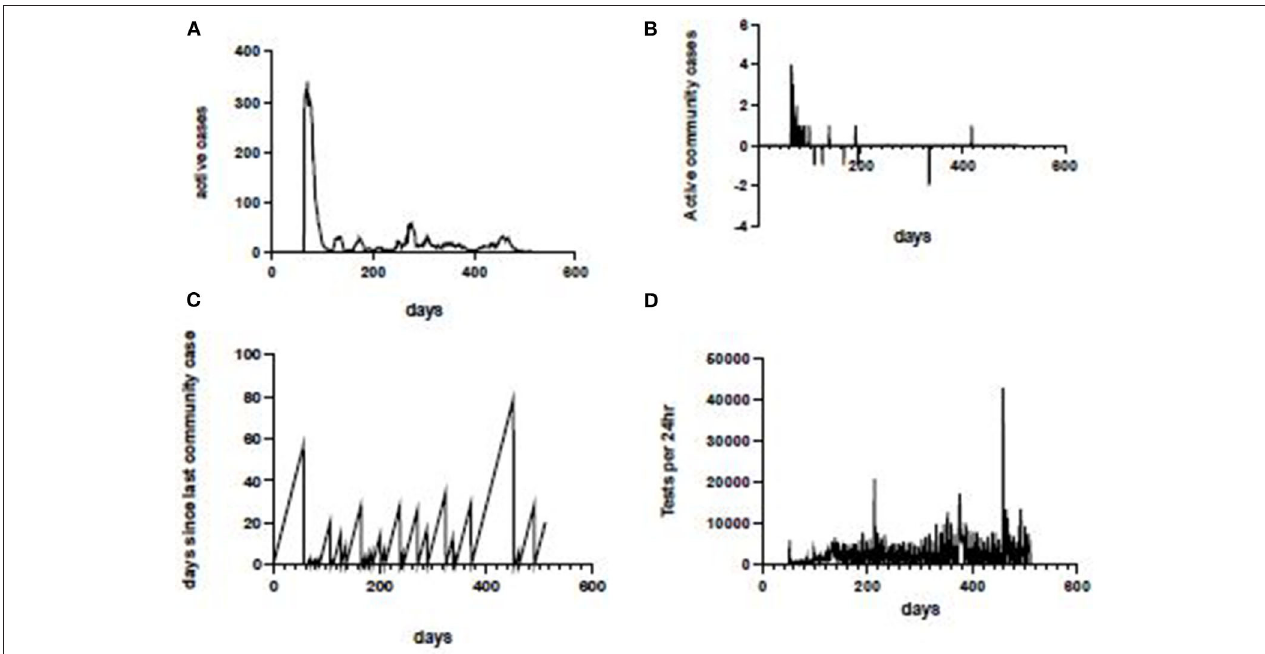
FIGURE 3 | COVID-19 critical information, Western Australia. Laboratory-confirmed COVID-19 cases in Western Australia(WA) (top left); active community cases in WA (top right); interval in days since last community case in WA (bottom left); total RT-PCR tests for SARS-CoV-2 conducted in WA each 24h (bottom right).